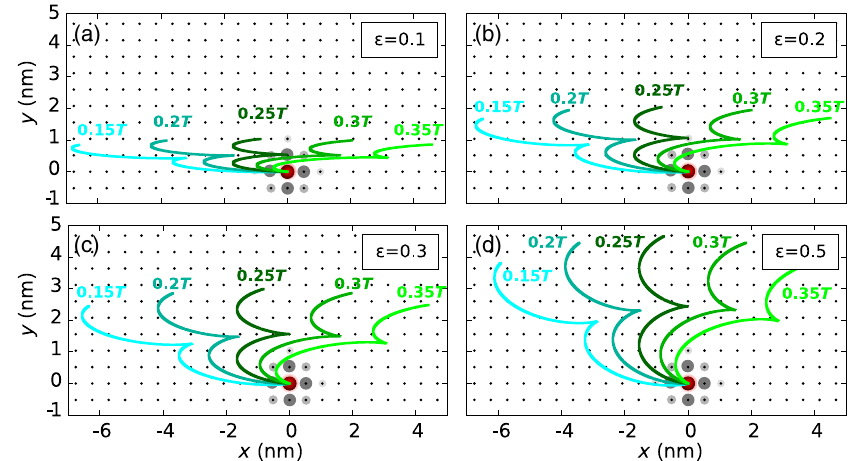
=E calculated by solving Newton ’ s equation of y x